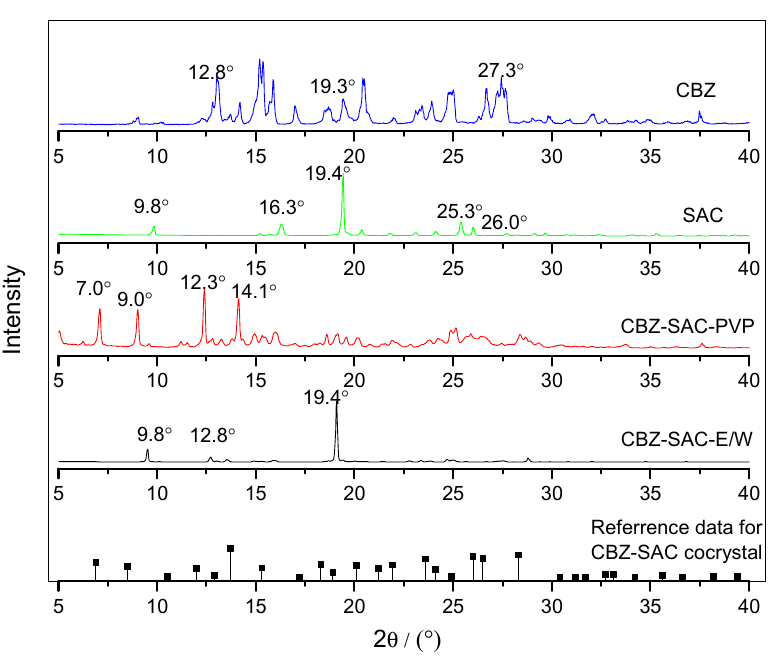
Figure 7. PXRD spectra of CBZ, SAC, CBZ-SAC-E/W, and CBZ-SAC-PVP.